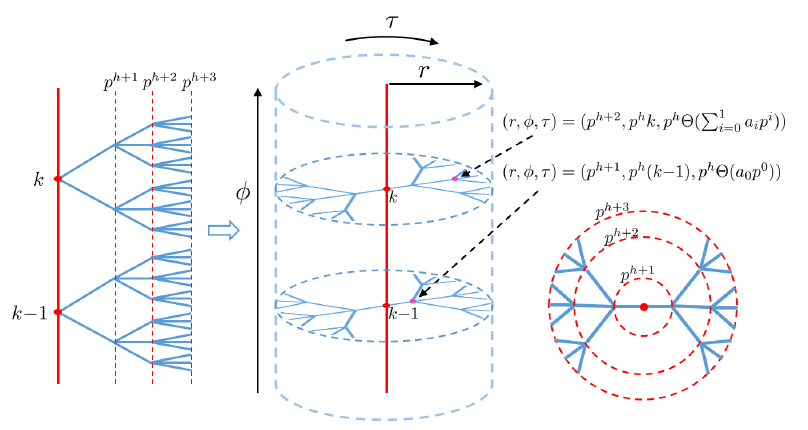
Figure 7. The cylinder type BH looks like a cylinder ( p = 3 ). The red line is its horizon. The right most picture shows the cross-section of the cylinder.